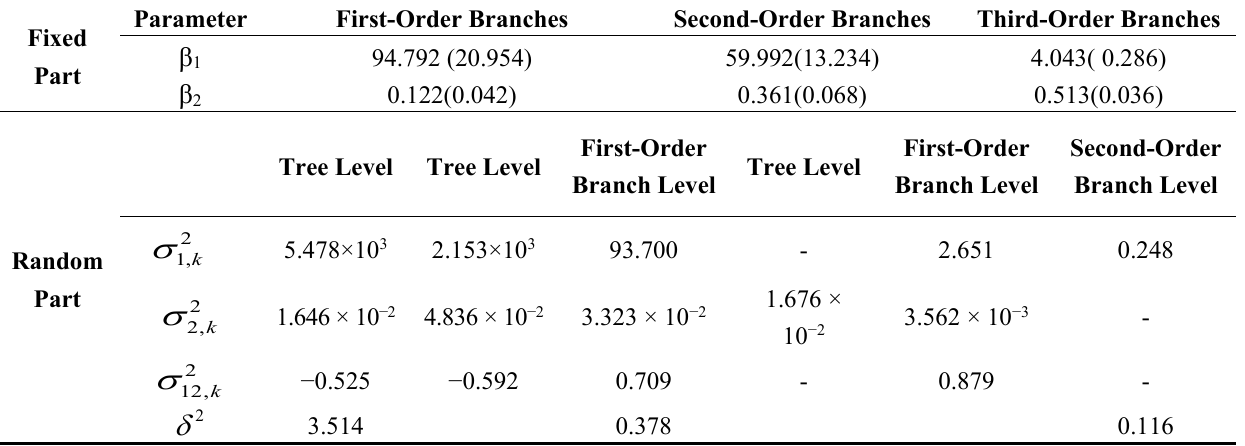
Table 6. Estimates of parameters for mixed models.